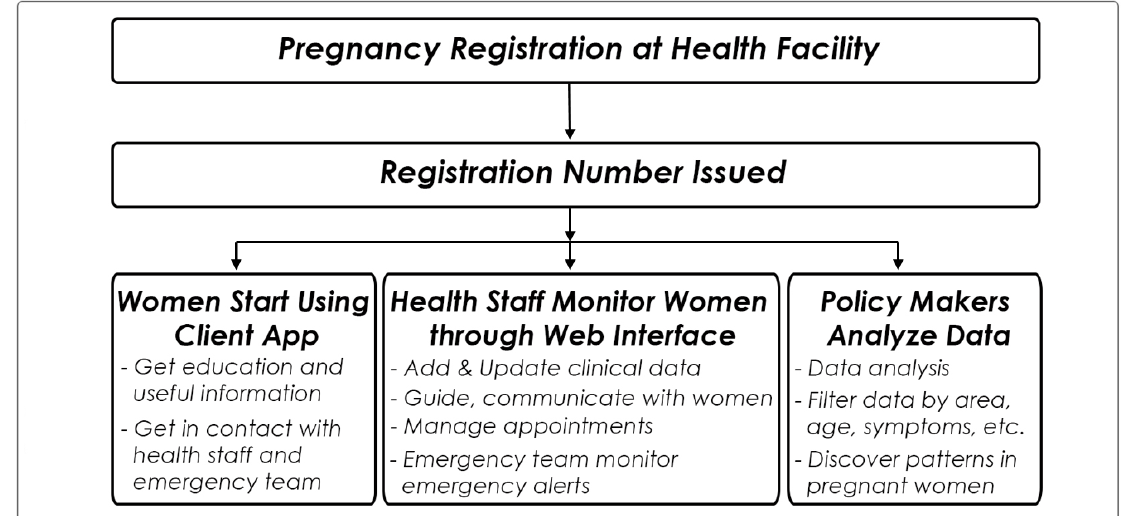
Figure 7. Information flow in the pregnancy care